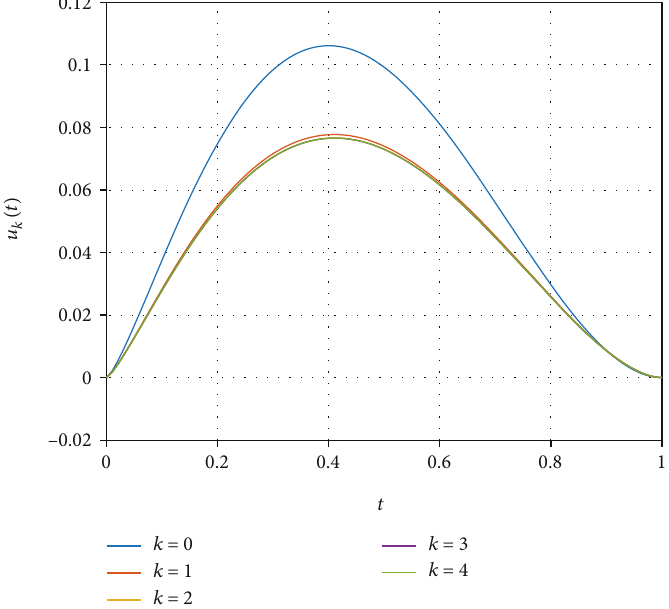
Figure 2: The approximation of the solution of problem